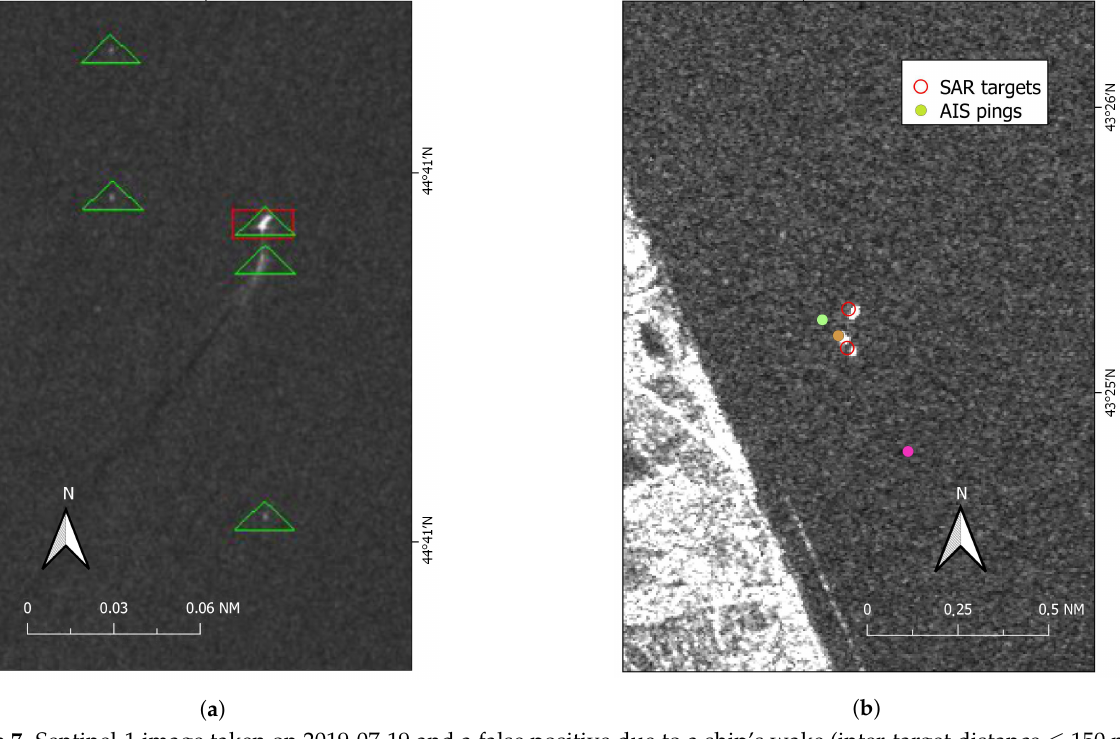
Figure 7. Sentinel-1 image taken on 2019-07-19 and a false positive due to a ship’s wake (inter-target distance ≤ 150 m). Green triangle and the red rectangles are objects detected in VH and VV, respectively ( a ). Close-up view of the 3 nm costal area (VH channel). 3 AIS positions were reported by a PTM (green ping), a cargo/cruise (orange ping) and a small OTB (pink) that according to its AIS, was below the limit of detectability for SUMO ( b